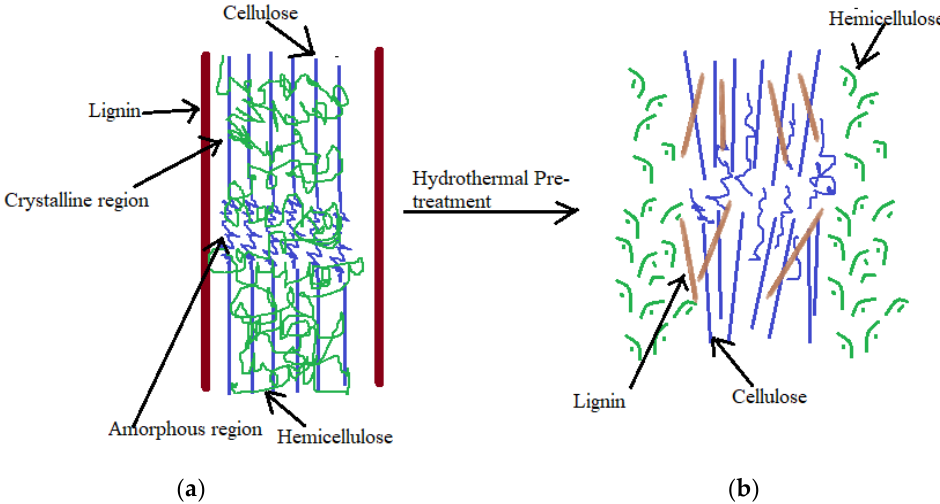
Figure 2. Effect of hydrothermal pre-treatment on the lignocellulosic biomass: ( a ) biomass without pre-treatment; ( b ) hydrothermal pre-treatment of lignocellulose (adapted with permission from Kumar et al. [48]. Copyright (2009) American Chemical Society)